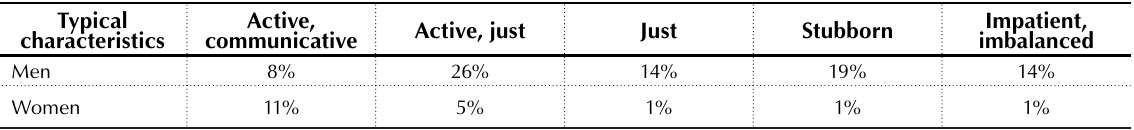
Source: elaborated by authors based on research results.